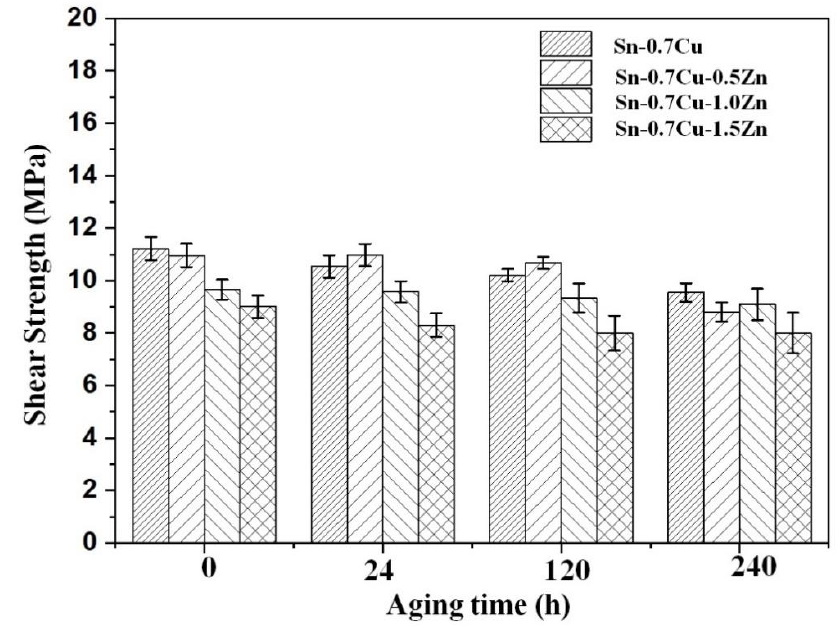
Figure 15. Shear strength after thermal annealing at 180 °C.